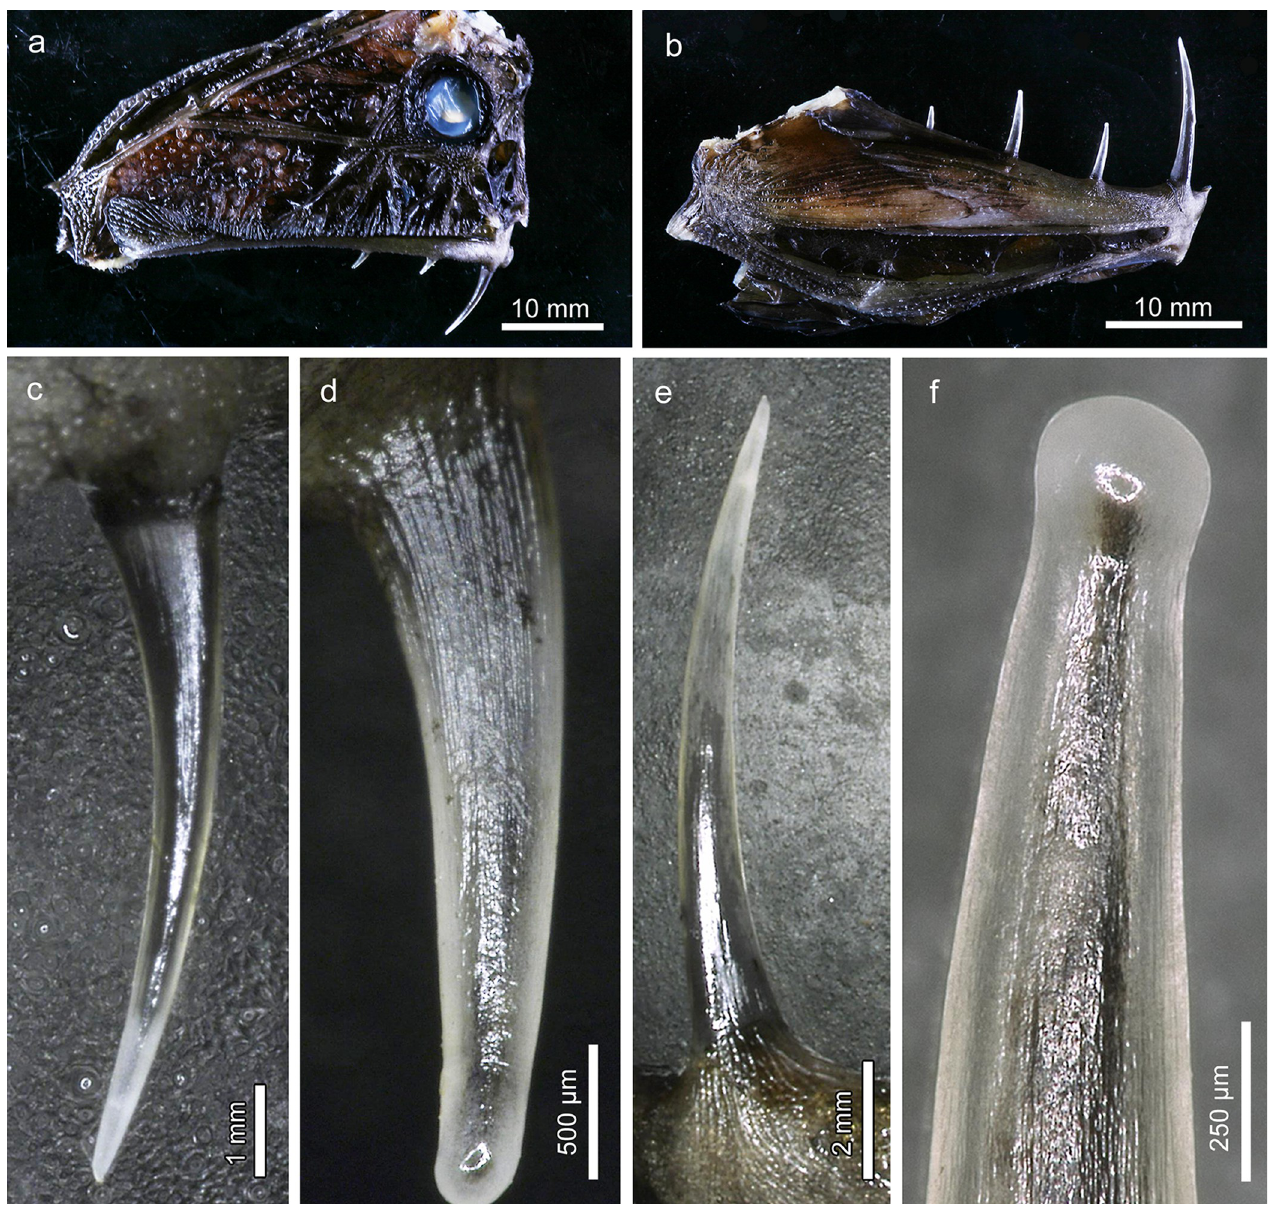
Fig 1. Oral jaw teeth in Anoplogaster cornuta . (a) Right lateral view of head showing the three teeth on the premaxilla. (b) Right lateral view of the lower jaw showing the four teeth on the dentary. (c) Right first premaxillary tooth, lateral view. Note transparency of the dentin and pointed tooth tip. (d) Right third premaxillary tooth, lateral view. Note rounded tooth tip. (e) Left first dentary tooth, lateral view. Note pointed tooth tip. (f) Rounded, knob-like tip of right second dentary tooth, medial view. Due to the transparency of the dentin the extension of the pulp cavity is visible. attachment. The mineralized anterior connection forms a hinge point with an anterior axis of rotation. In Type 4 (posterior-hinged attachment), the collagenous connection between tooth base and bone of attachment is missing anteriorly; instead, a gap (dividing zone) is present between tooth base and bone at this location. An unmineralized collagenous connection is present only posteriorly, providing a hinge with a posterior axis of rotation [4,7].